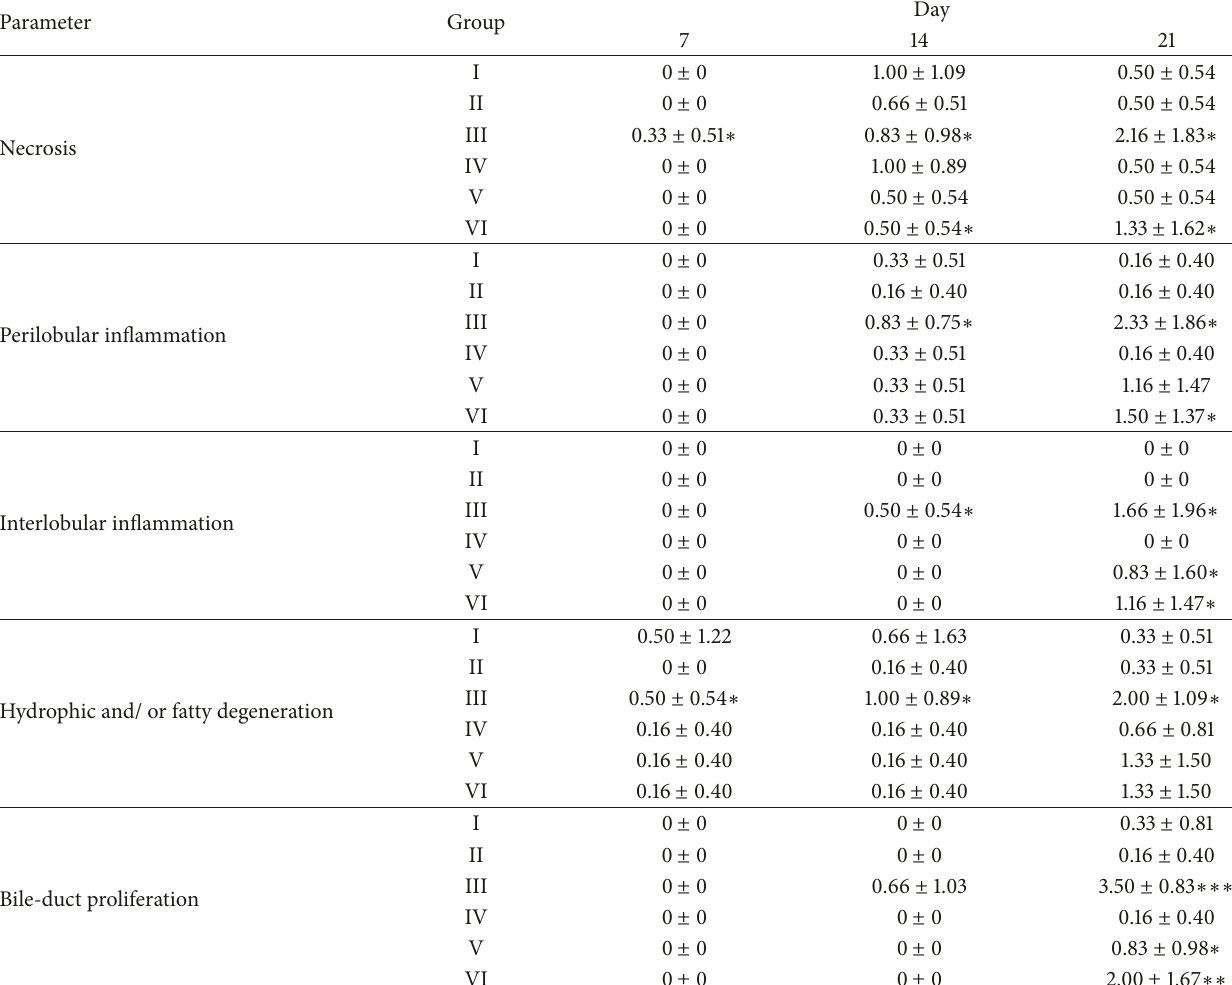
Table 8: Effects of 5% SAP on the liver histopathology of broiler chickens fed a diet naturally contaminated with AF at 7, 14, and 21 days of